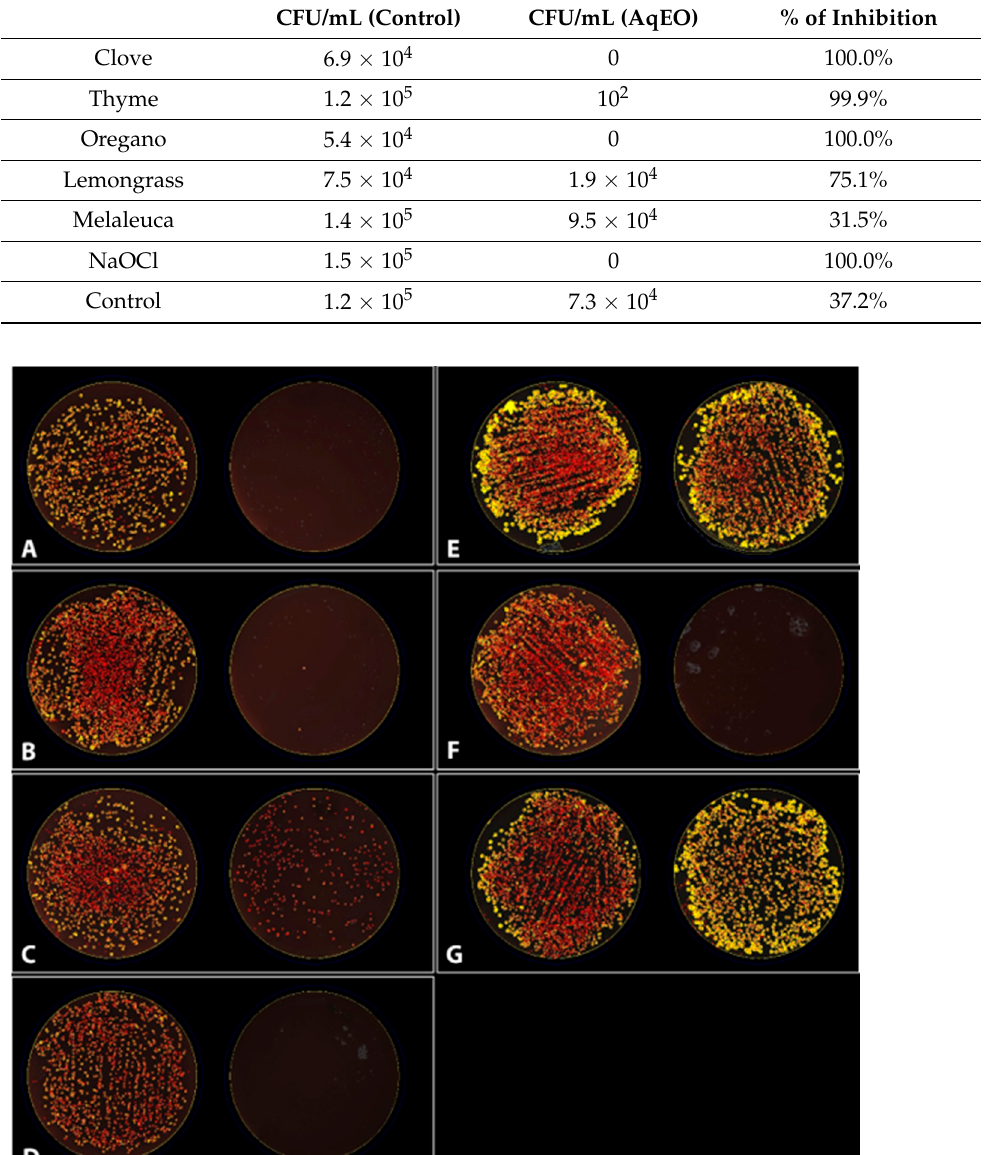
Table 1. Effect of AqEO on E. faecalis growth.